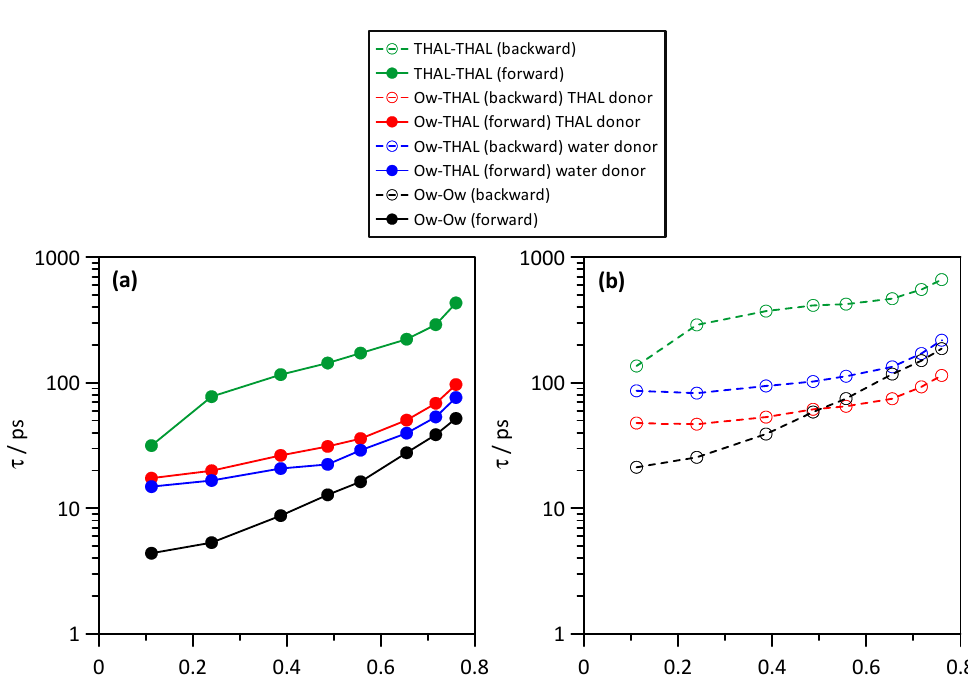
Figure 14. Kinetic parameters of hydrogen bonding for the reported interacting sites showing relaxation times, τ , for the ( a ) forward, i.e., hydrogen bond lifetime, and ( b ) backward, i.e., hydrogen bonding reformation after destruction, processes in ω THAL + (1- ω ) water mixtures at 310 K. Atom labels as in Figure 1. For THAL molecule, all available OH sites (O1 to O4, Figure 1) are considered as donor or acceptors.